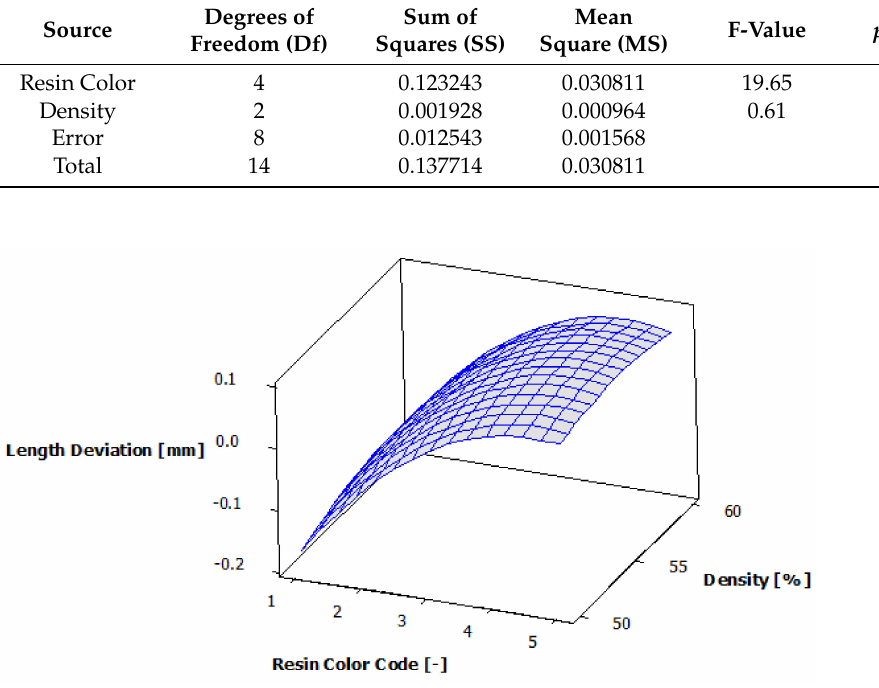
Figure 8. Estimated response surface for length